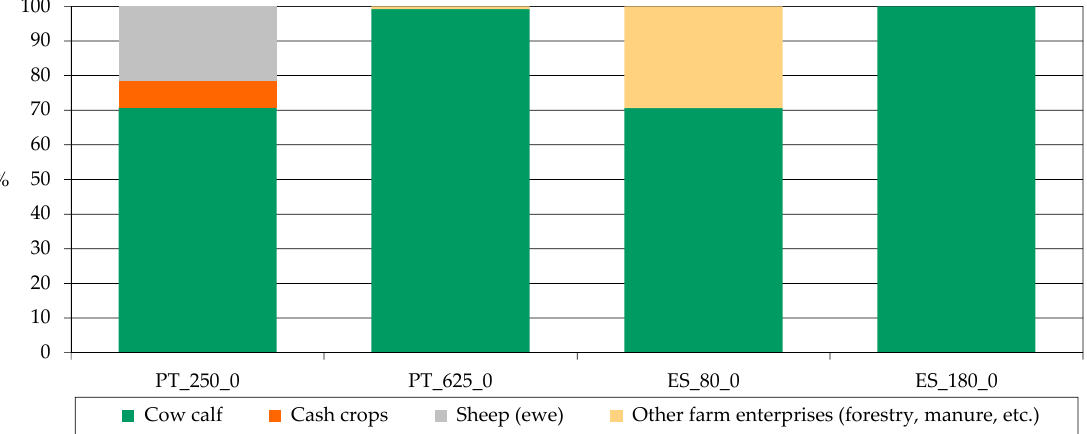
Figure 1. Return Structure (% of different farm activities on total farm returns). Source: model results.